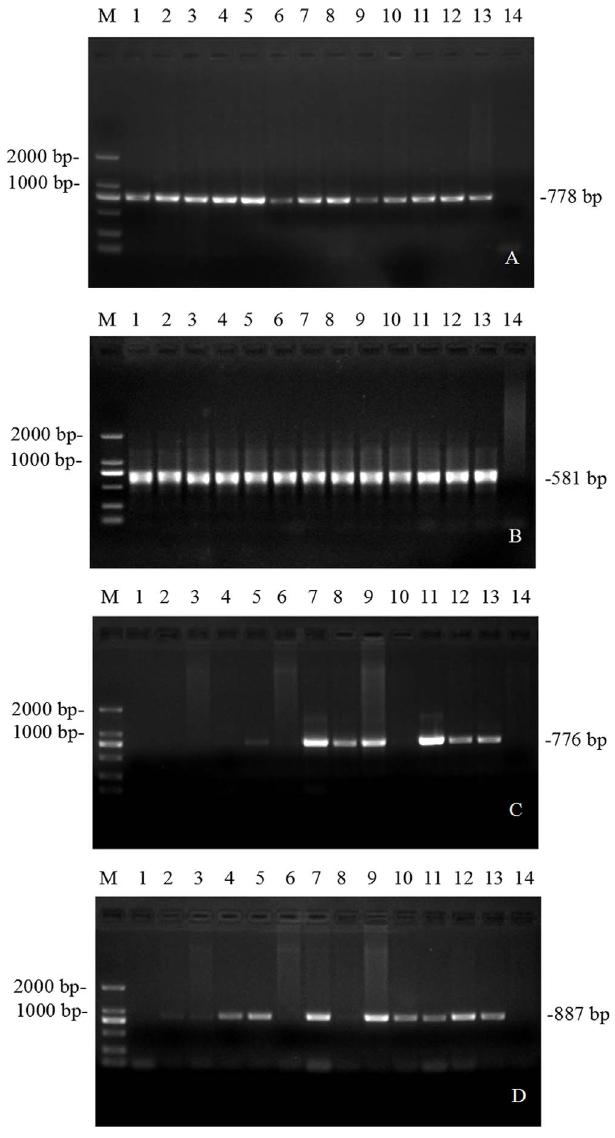
DNA Marker, lain1: Positive control, lain2-13: Sample products, lain14: Negative control. (C) and (D) T. orientalis PCR and T. sinensis PCR, M: DL 2000 DNA Marker, lain1-13: PCR products of the target gene, lain14: Negative